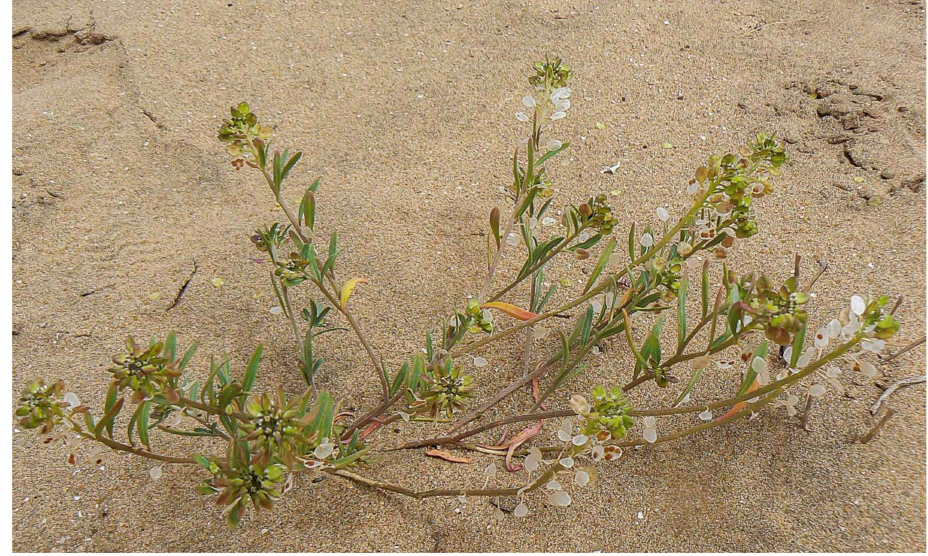
Figure 1. The aerial parts of L. libyca (Viv.) Meisnner plants (leaves and flowers) (source: Fouad